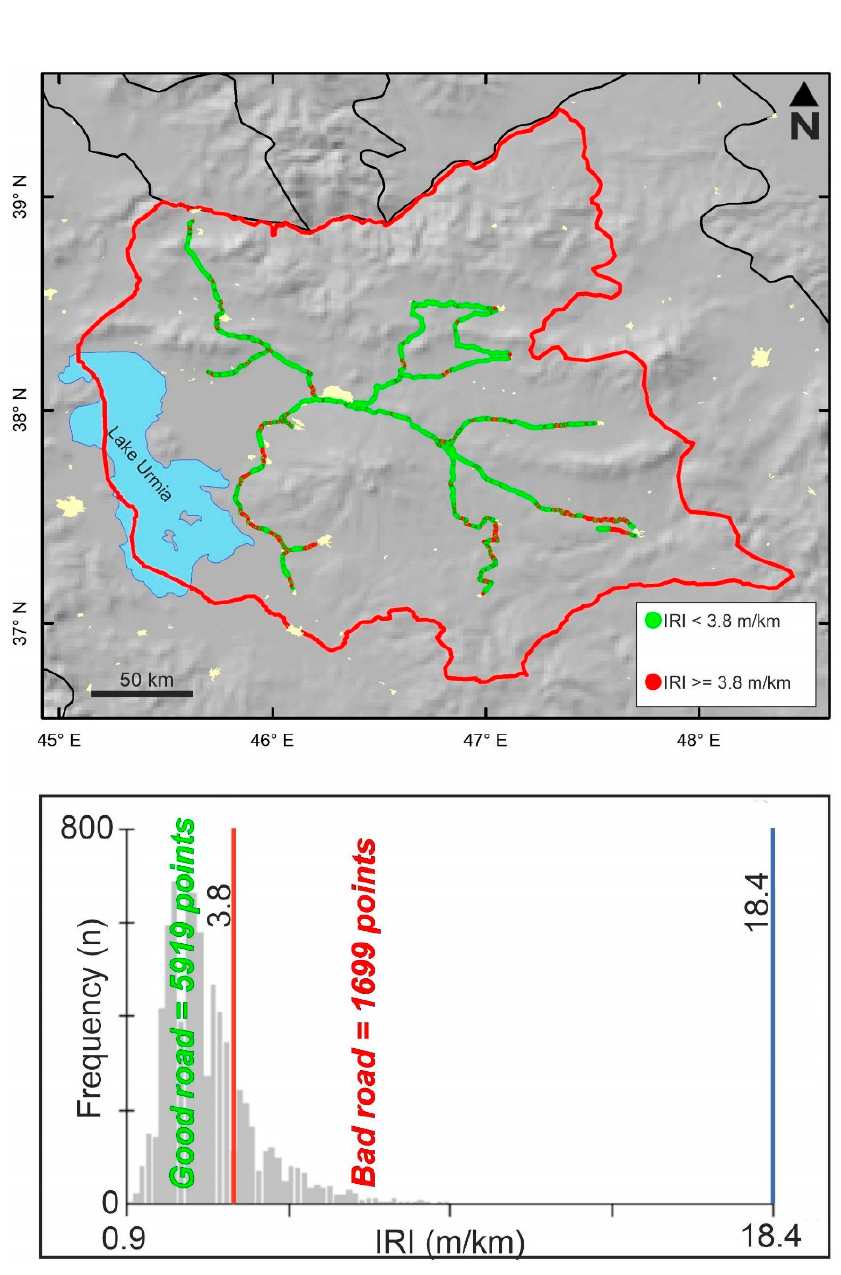
Figure 5. Binary road quality map based on a Jenks classification for IRI